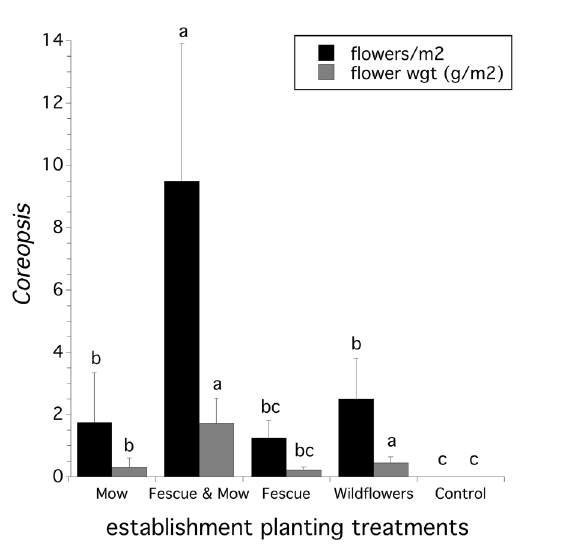
Figure 5: 2015 Coreopsis lanceolata flower density and dry weight per m 2 . Significant differences are denoted by letters. When letters are different, differences are